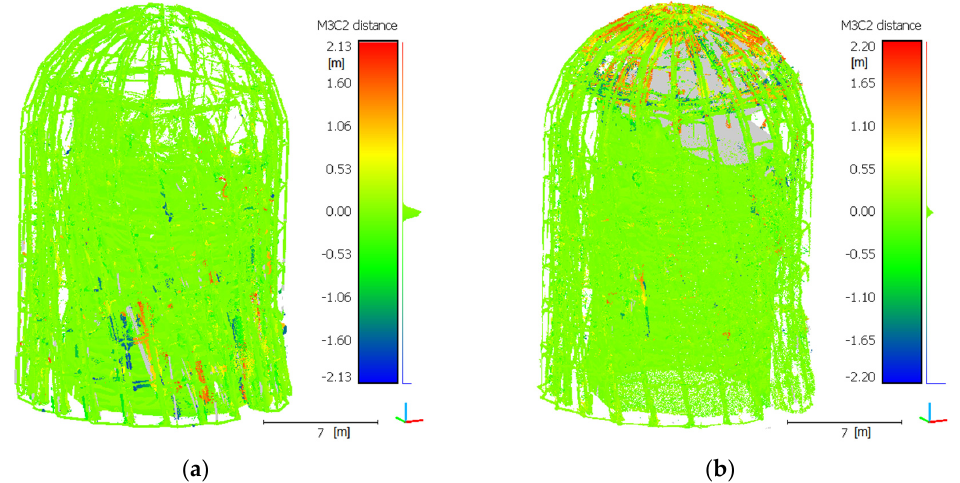
Figure 12. The M3C2 distance for integrated point clouds: ( a ) the distance projected on TLS points; ( b ) the distance projected on UAV points.